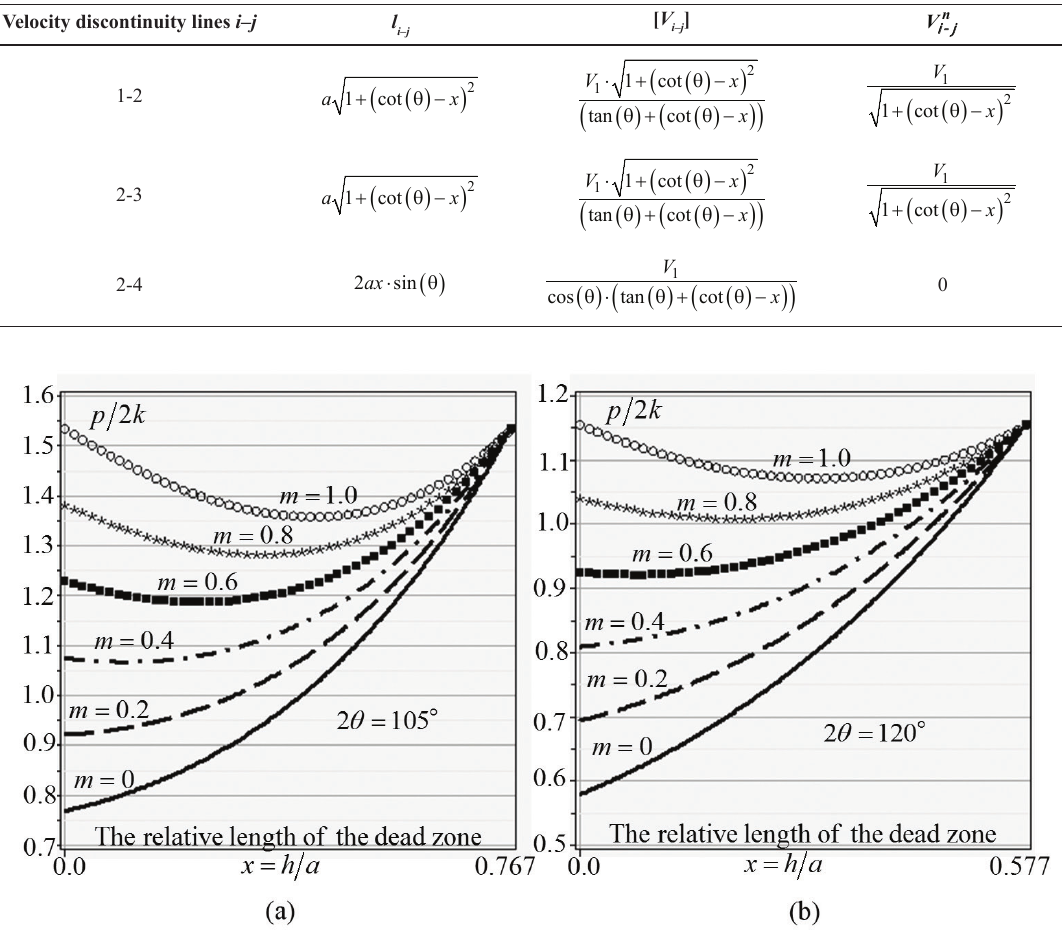
Figure 4. Dependences of relative punching pressure p /2 k with respect to x = h / a for workpieces ECAE through Segal 2θ -dies with channel intersection angles 2 θ =105° ( a ) and 2 θ =120° ( b ) for the following friction factor m values: ▬▬▬ ( m=0 ), ▬▬ ▬▬ ( m=0.2 ), ▬▬ ■ ▬▬ ( m=0.4 ), ■ ■ ■ ■ ( m=0.6 ), ✴✴✴✴✴ ( m=0.8 ) and 〇〇〇〇〇 ( m=1.0